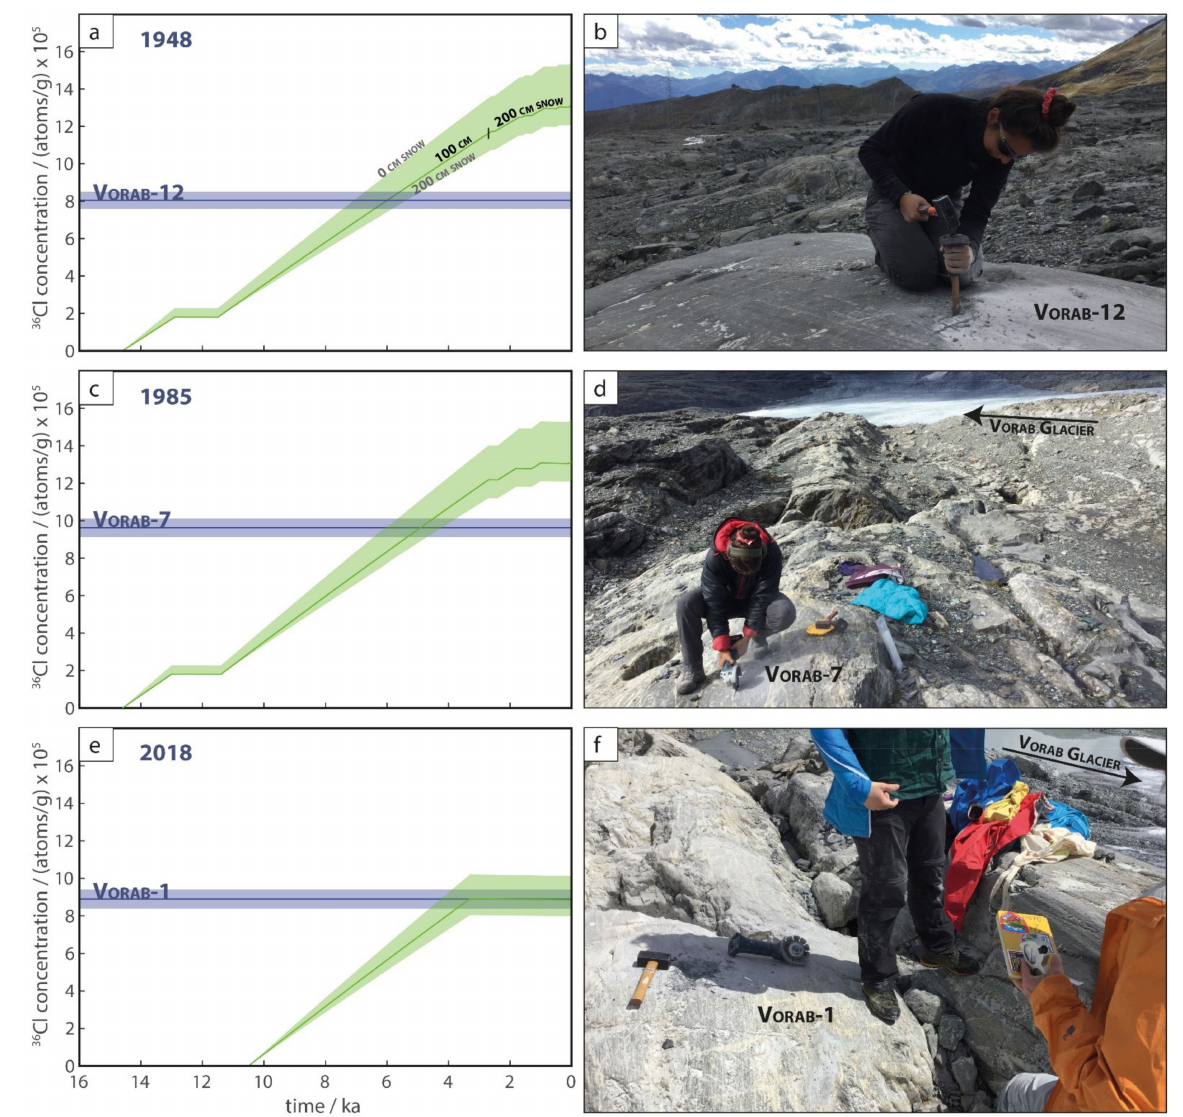
Figure 7. ( a , c , e ) MECED model output for a representative sample (Vorab-12, Vorab-7, Vorab1) of each group (1948, 1985, 2018) inside the LIA extent, showing the increase in 36 Cl during ice-free periods and no production during phases of glacier coverage (stays flat). ( b , d , f ) shows a photo of the corresponding sample. For a detailed description of the diagrams see caption of Figure 6. See Figures 2 and 3 for the location of samples and